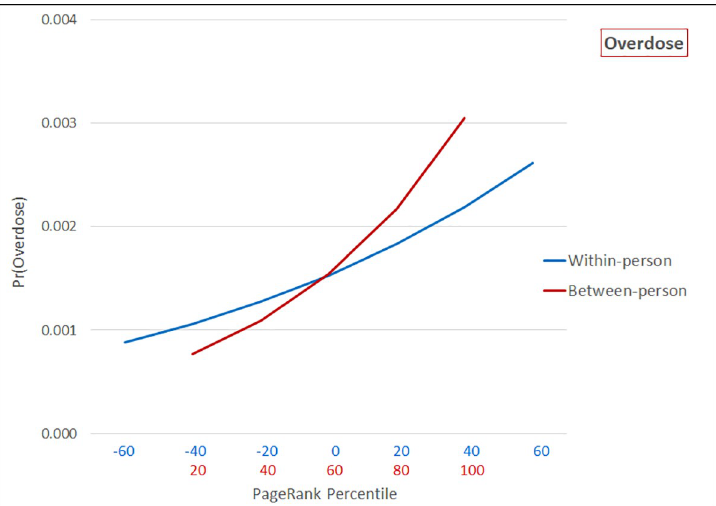
Fig 3. Predicted probability of overdose as a function of within-person and between-person PageRank percentile (n = 526,914; n obs = 2,107,656).